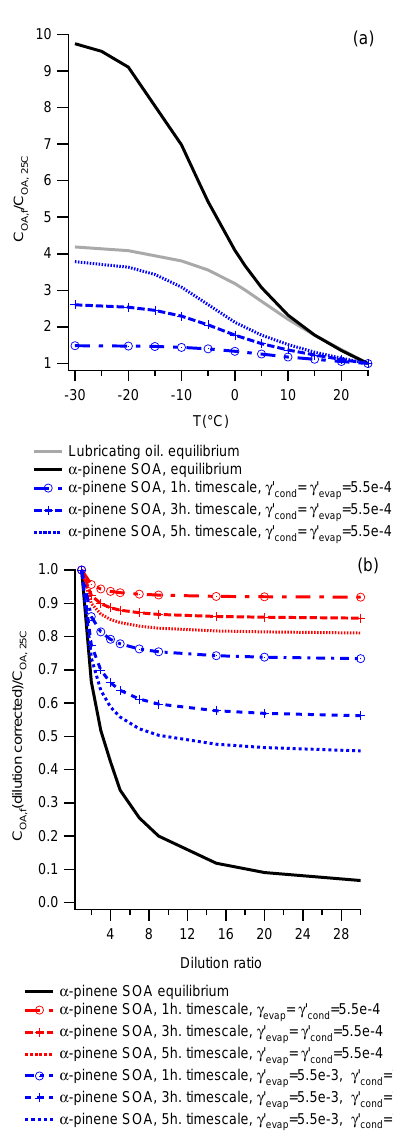
Fig. 13. (a) Condensed mass forming potential of lubricating oil and α -pinene SOA resulting from cooling from initial conditions at 25 ◦ C and 20µgm − 3 aerosol loading. For the α -pinene SOA aerosol, the cases presented are (1) equilibrium, assuming that gas condensation is not affected by the particle phase and (2) non- = γ evap . A strong difference is equilibrium conditions with γ 0 cond obtained in the particle mass change estimation, depending on the assumption of condensation being or not affected by the parti- cle amorphous solid state. (b) Change in α -pinene SOA aerosol mass resulting from dilution-induced evaporation for the cases of (1) equilibrium (2) non-equilibrium with γ 0 evap = γ 0 and (3) non- cond =1. While the equilibrium equilibrium with γ 0 evap =5e–3 and γ 0 cond partitioning calculations significantly overestimate the amount of amorphous solid aerosol mass evaporated due to dilution, a large difference in the estimation of aerosol mass is obtained depending on the assumption of effective evaporation